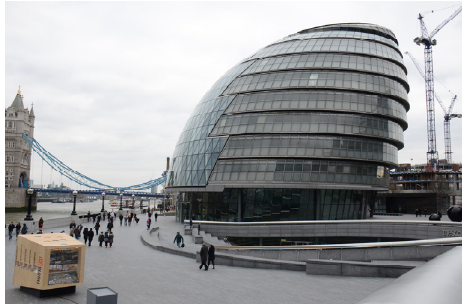
Figure 1. London City Hall—Foster and Associates (Courtesy Terri Boake, University of Waterloo).